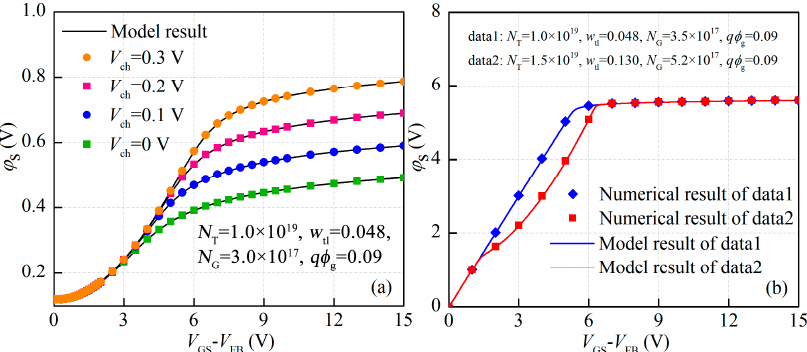
Figure 2. Comparison of the surface potential solution with the numerical result for ( a ) different values of V ch and ( b ) various DOS distributions. Table 1. Key parameters used in the model.